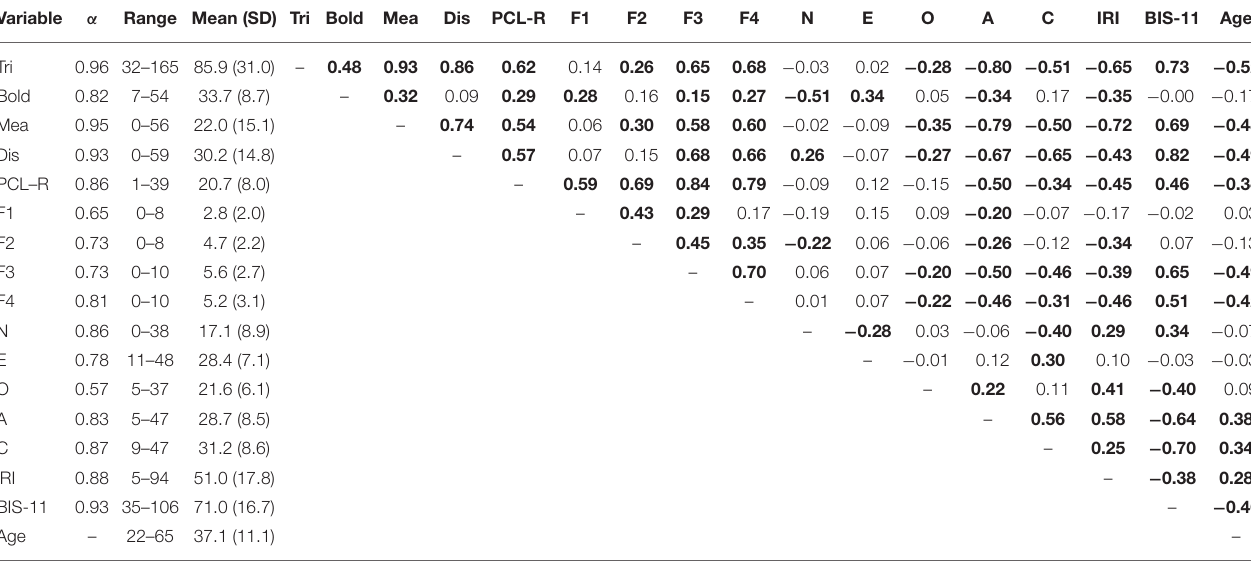
TABLE 1 | Internal consistency values, range, mean values, standard deviations, and correlations matrix for all continuous variables. Variable α